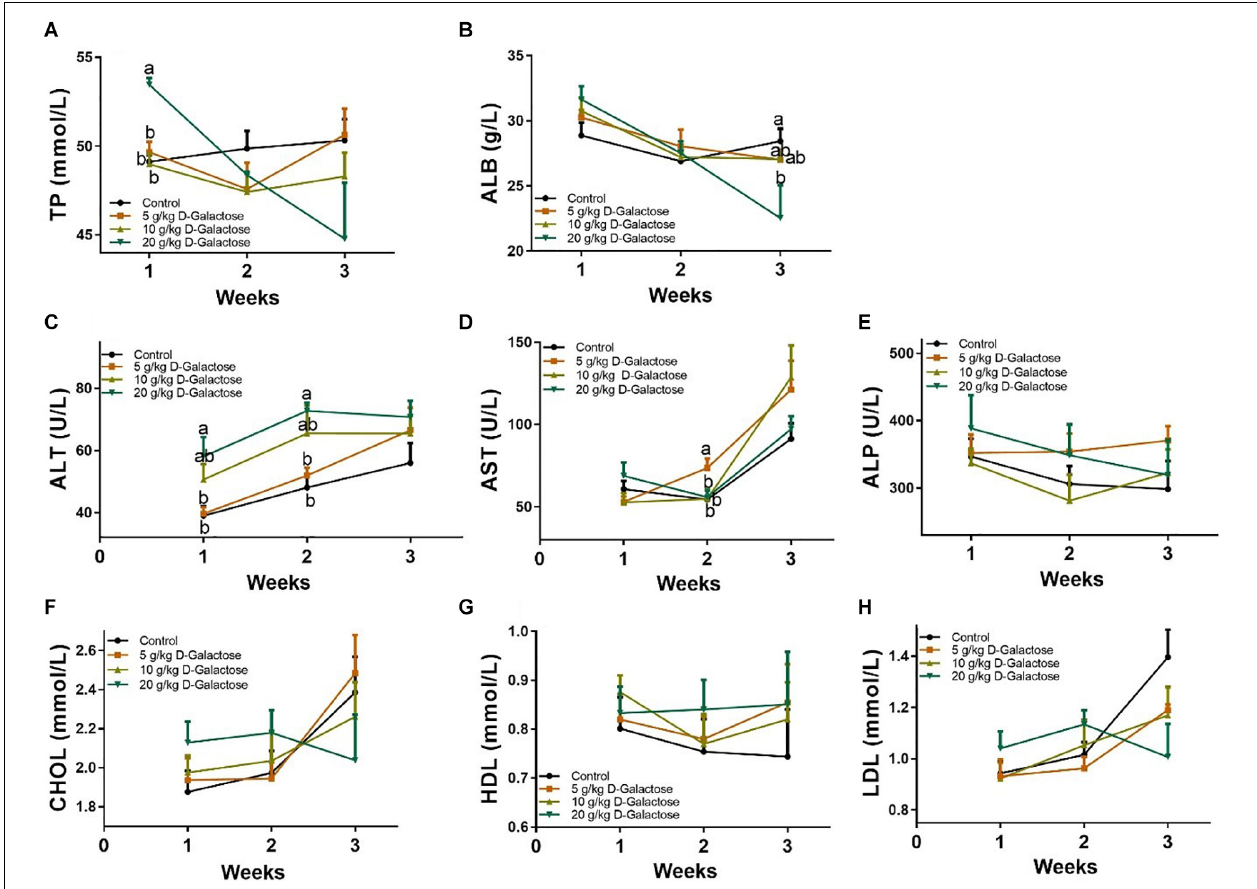
FIGURE 3 | Effects of D -galactose on serum biochemical parameters. (A) TP; (B) ALB; (C) ALT; (D) AST; (E) ALP; (F) CHOL; (G) HDL; (H) LDL. Data were expressed as the mean ± SEM. Different lower-case letters indicate a significant difference among different dosage of D -galactose ( P <